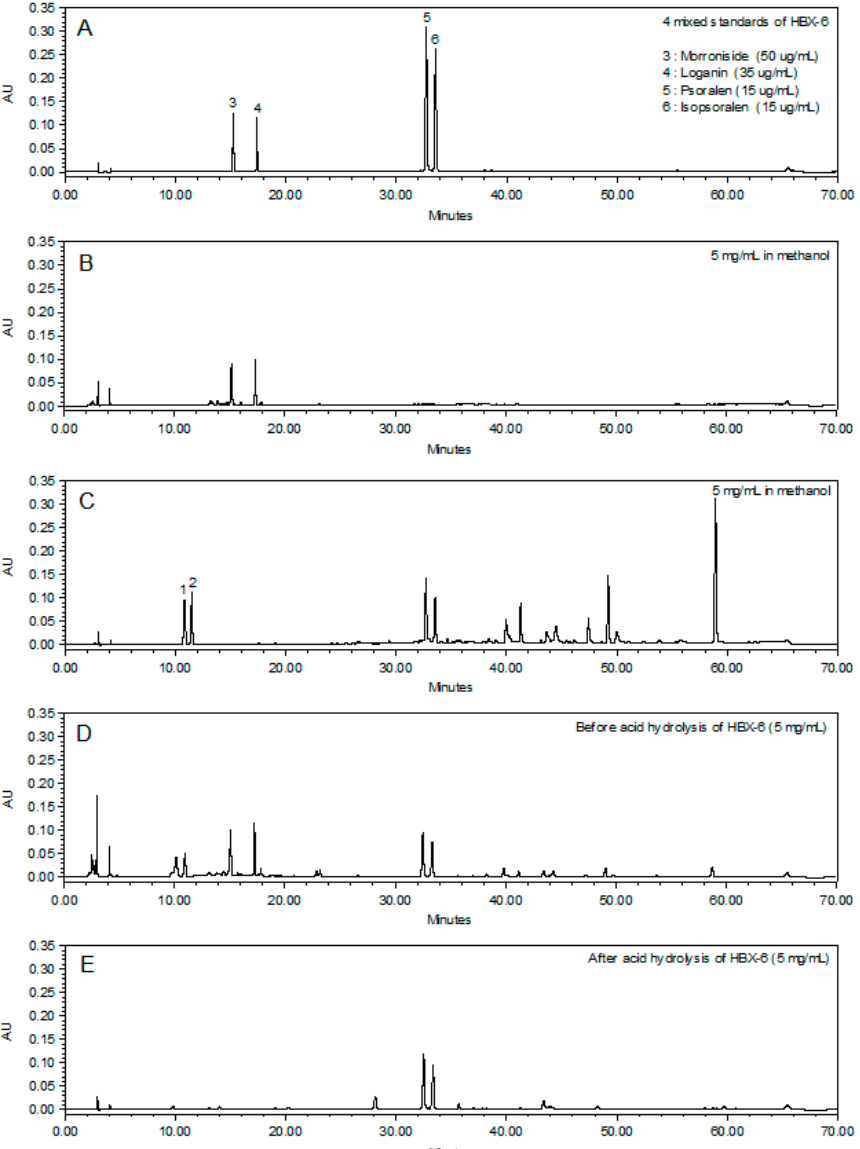
Figure 4. Representative HPLC chromatograms of ( A ) mixed standards, ( B ) Cornus officinalis Sieb. et Zucc., ( C ) Psoralea corylifolia L., ( D ) HBX-6 before acid hydrolysis and ( E ) HBX-6 after acid hydrolysis. (1) psoralenoside; (2) isopsoralenoside; (3) morroniside (4) loganin (5) psoralen; (6) isopsoralen. The